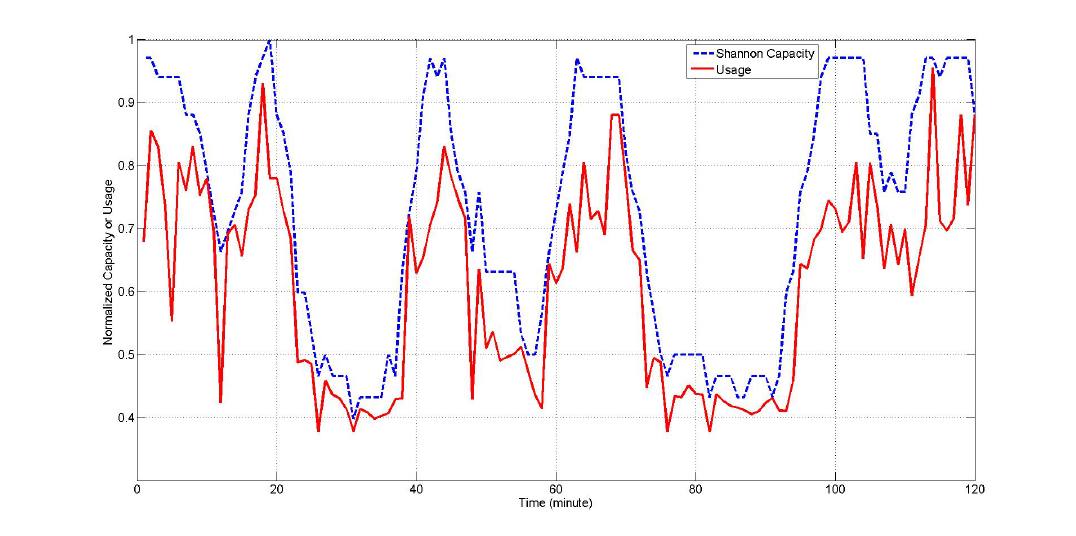
Figure 9. Comparison between normalized channel usage with channel capacity prediction based on a three-point prediction algorithm incorporating data transmission during non-bursty (steady) traffic